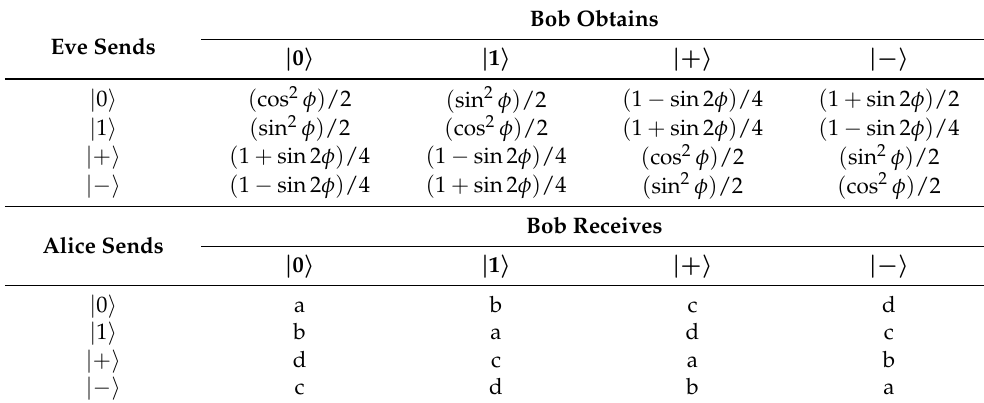
Table 2. A summary of joint probabilities for states prepared by Alice and Bob’s measurement outcomes corresponding to each of the four states when given Eve’s intercept-and-resend